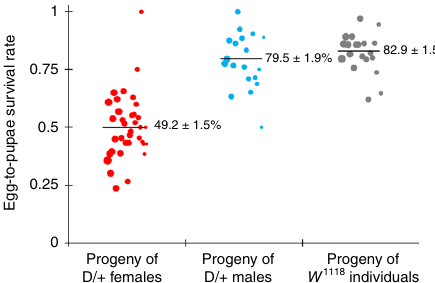
Fig. 5 Egg-to-pupae viability. Females and males heterozygous for the drive allele and the Cas9 allele were crossed with w 1118 individuals, and w 1118 males and females were crossed together. Eggs were counted in 20-h intervals, and pupae were counted 9 days later. Eggs from female drive heterozygotes had substantially lower viability, as expected with a mechanism in which maternal Cas9 activity creates recessive disruption in h . The size of the dots represents egg sample size from a single female. The rate estimates and corresponding estimates of the standard error of the mean (SEM) are displayed, obtained from pooling offspring from all crosses of the same type together ( n = 1144 for the progeny of drive females, n = 464 for the progeny of drive males, and n = 655 for the progeny of w 1118 individuals). An alternative statistical analysis that accounts for potential batch effects was also performed but yielded overall similar rates with only slightly increased error estimates (Supplementary Methods, Source Data: Data Sets 1 −